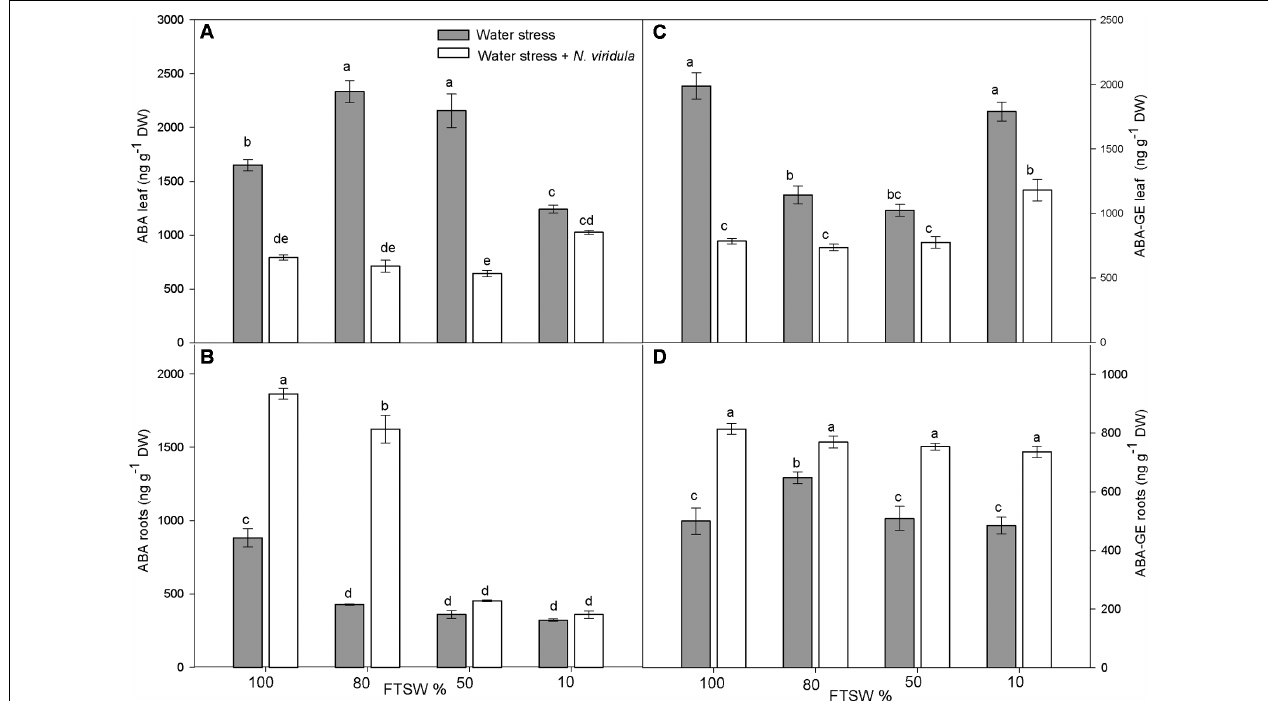
FIGURE 2 | Quantitative measurements (ng g − 1 DW) of ABA and its metabolite ABA-GE in well-watered and water-stressed broad bean plants with or without N. viridula infestation. Abscisic acid (ABA; A,B ) and abscisic acid glucose ester (ABA-GE; C,D ) contents in leaves (A,C) and roots (B,D) of V. faba plants under developing water stress (gray bars) and with an associated presence of N. viridula infestation (white bars). Measurements were made at 100, 80, 50, and 10% of FTSW. Data are means ± SE ( n = 8). Different letters indicate significant differences ( P <